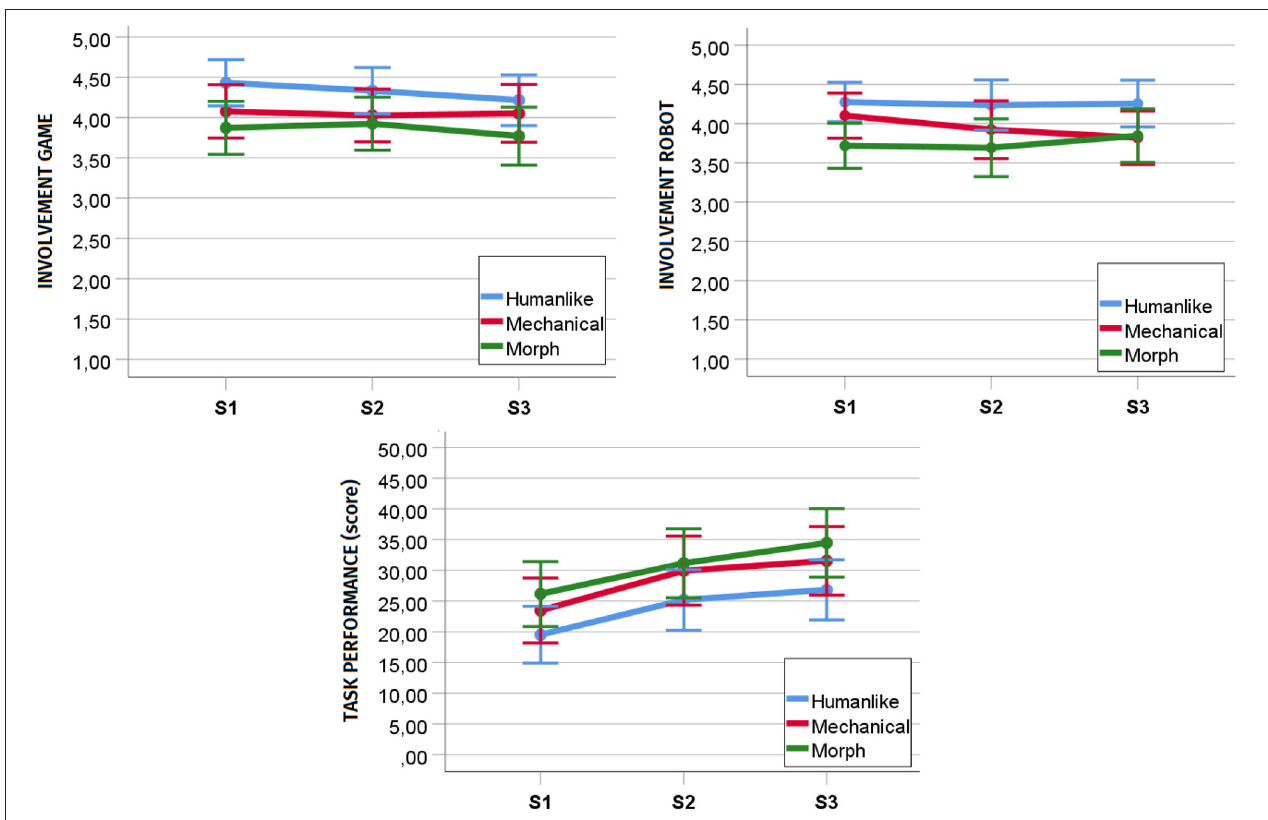
FIGURE 5 | Development of involvement with the game, involvement with the robot, and task performance (participants’ score at the game) over repeated sessions. S1, Session 1; S2, Session 2; S3, Session 3.